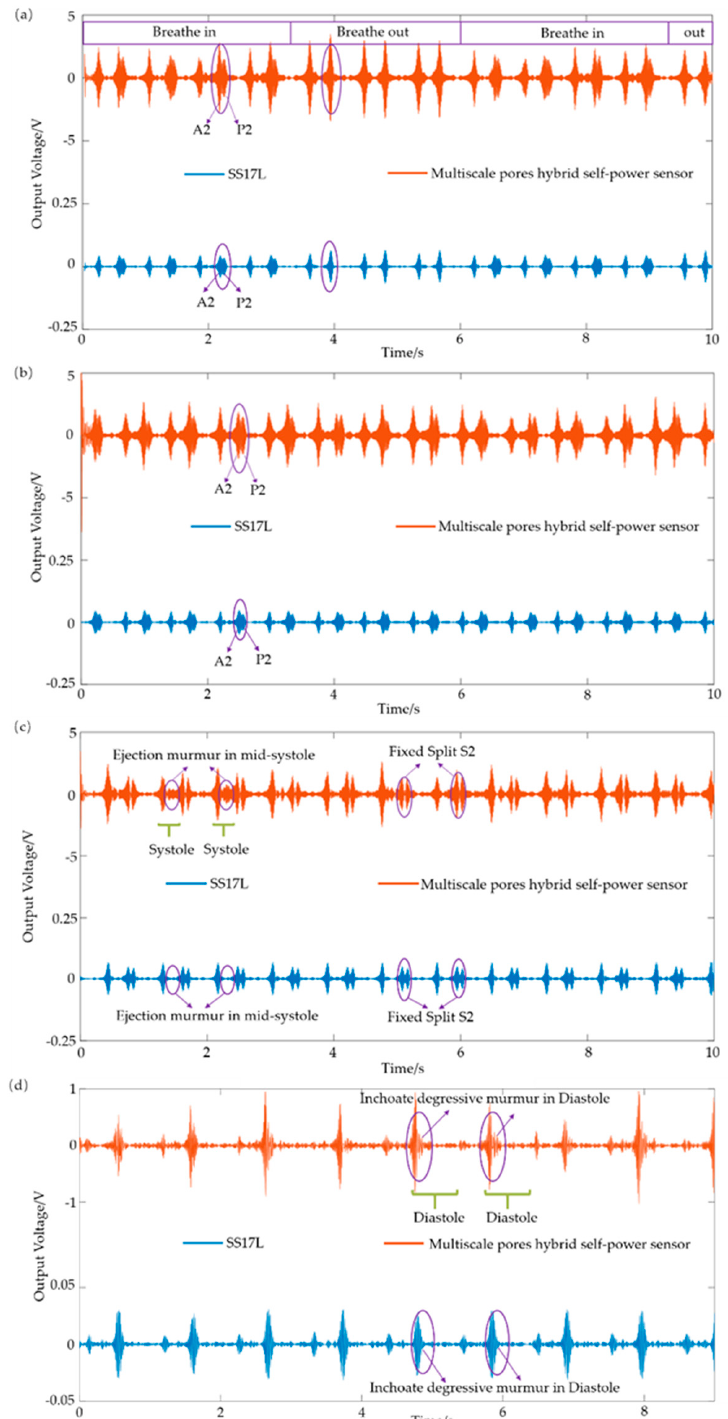
Figure 9. Schematic of pathological heart sound detection of SS17L (BIOPAC, Goleta, California, USA) and the proposed sensor. Representative features of ( a ) heart sound signal with a transient S2 split, ( b ) heart sound signal with a fixed S2 split, ( c ) heart sound signal of aortic regurgitation, and ( d ) heart sound signal of an atrial septal defect.